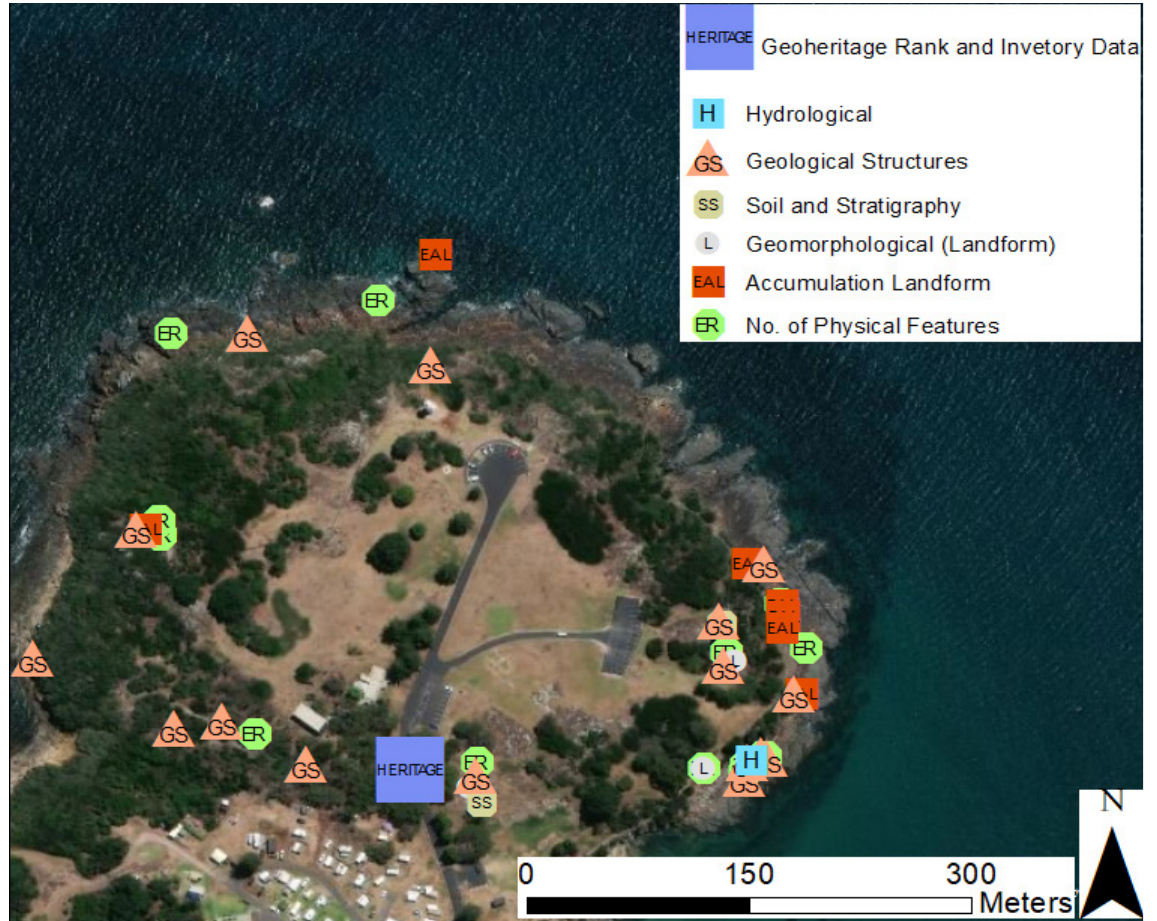
Figure 4. Example of all data captured from ArcGIS QuickCapture and Survey123 compiled into the one map, uploaded to ArcGIS Online, with geoheritage attributes associated and joined with a standalone heritage point (© ESRI background aerial